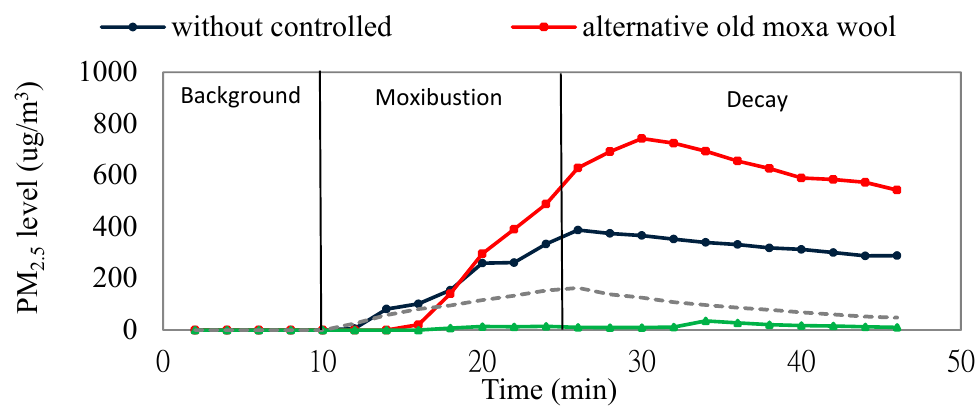
Figure 4. Comparison among the increasing measurements of indoor air pollutants from moxibustion emission inside the acupuncture and moxibustion room. Table 1. Comparison between average values of mean levels of air pollutants emitted from burning new moxa wools and alternate old moxa